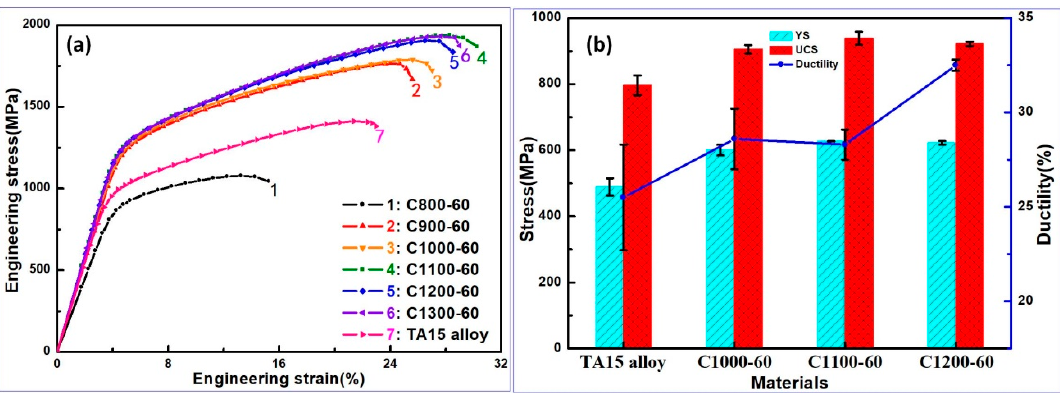
Figure 7. The compressive engineering stress–strain curves of the composites sintered at different sintering temperatures and TA15 titanium alloy: ( a ) ambient temperature; ( b ) 600 °C.